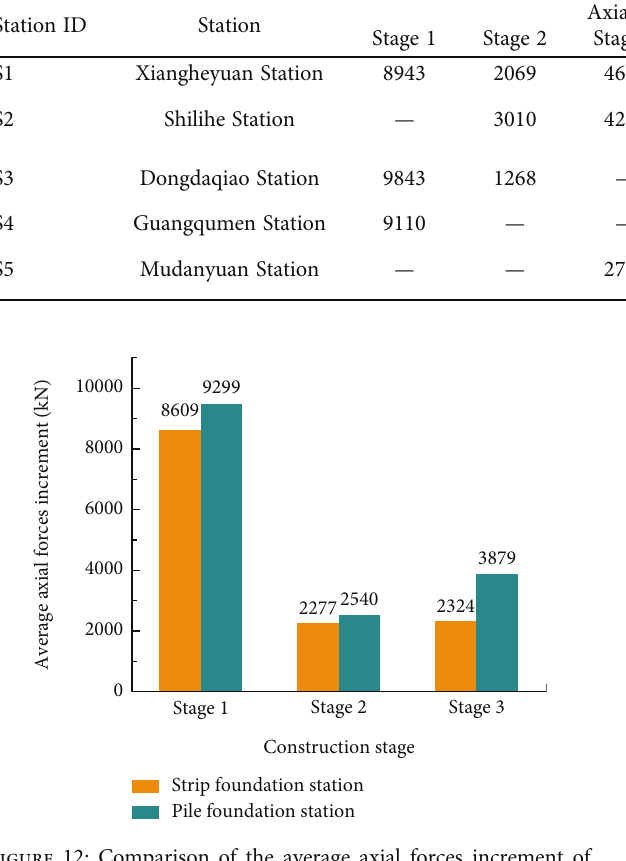
Figure 12: Comparison of the average axial forces increment of steel pipe columns of two types of subway stations in di ff erent construction stages.